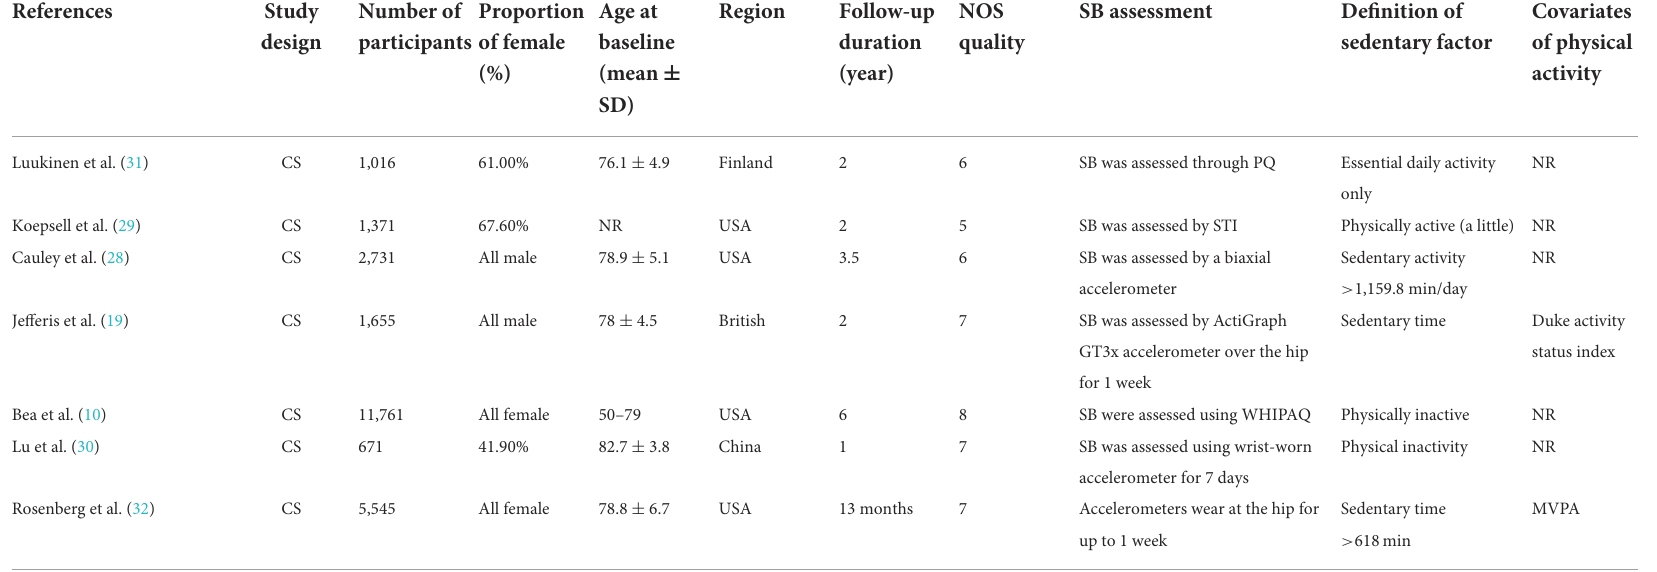
TABLE 1 Demographic characteristics of included